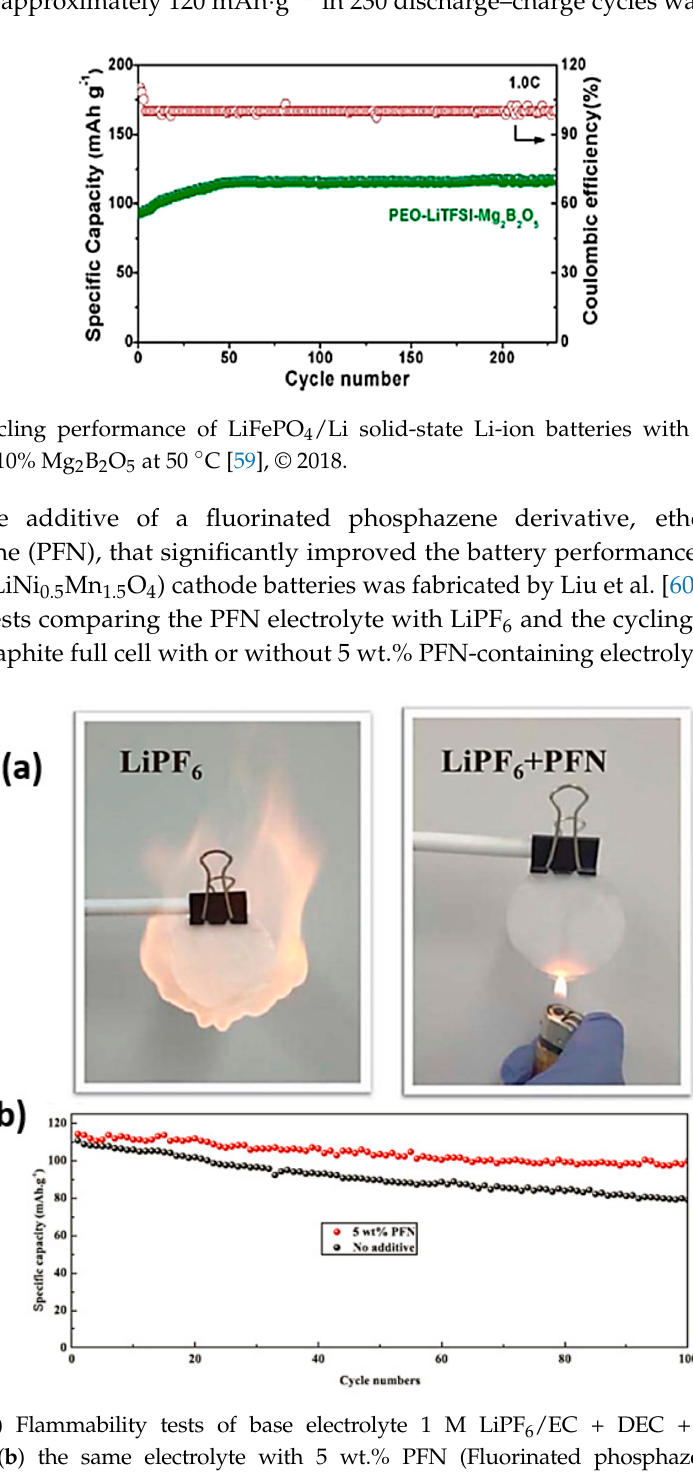
Figure 20. Flammability tests of base electrolyte 1 M LiPF 6 /EC + DEC + DMC ( v / v / v = 1/1/1) and